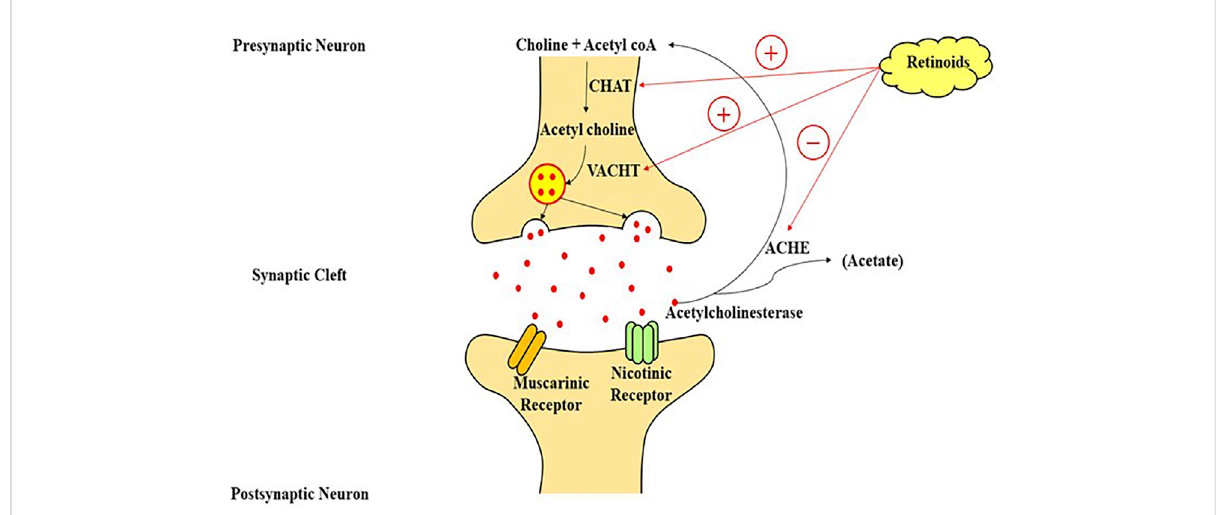
FIGURE 3 Amodelofretinoicacidsignalinginthecentralnervous system,whichplaysan importantroleinthestimulationoftranscriptionalmachineryto modulate the cholinergic neurotransmission through the production of choline-acetyl transferase mRNA and acetylcholine on the interaction of retinoicacidwithitsnuclearreceptors.CHAT, cholineacetyltransferase;VACHT,vesicularacetylcholine transporter;acetylcoA,acetylcoenzymeA; ACHE, acetylcholinesterase